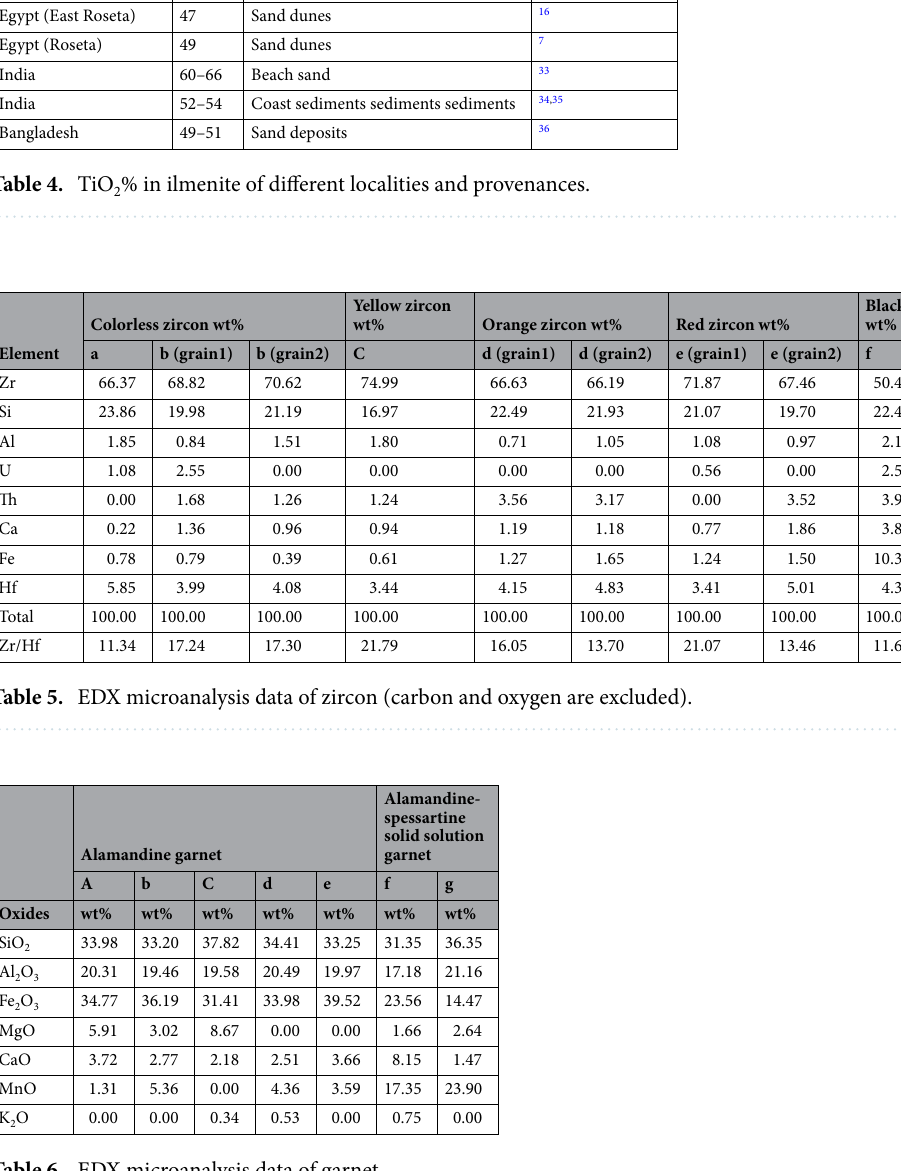
Table 6. EDX microanalysis data of